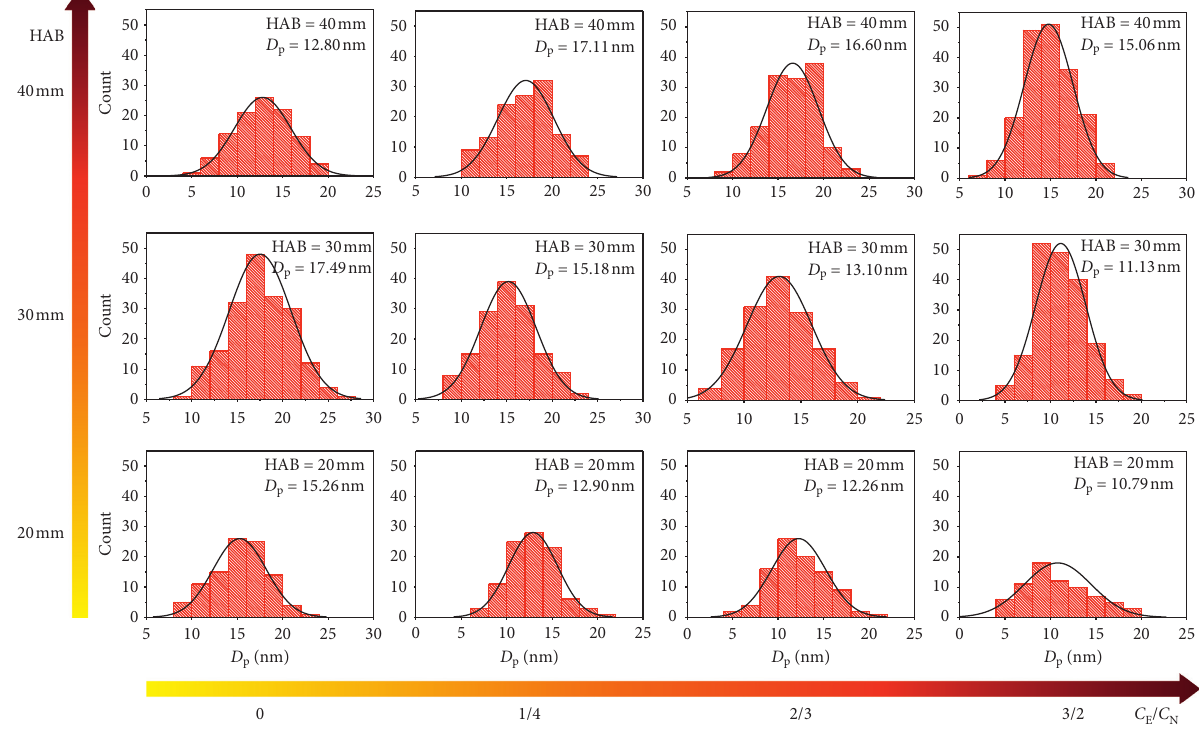
Figure 7: Statistical results of soot particle size in a laminar diffusion flame with n- heptane mixed with ethanol. Table 2: The average particle size of the primary soot at different heights.